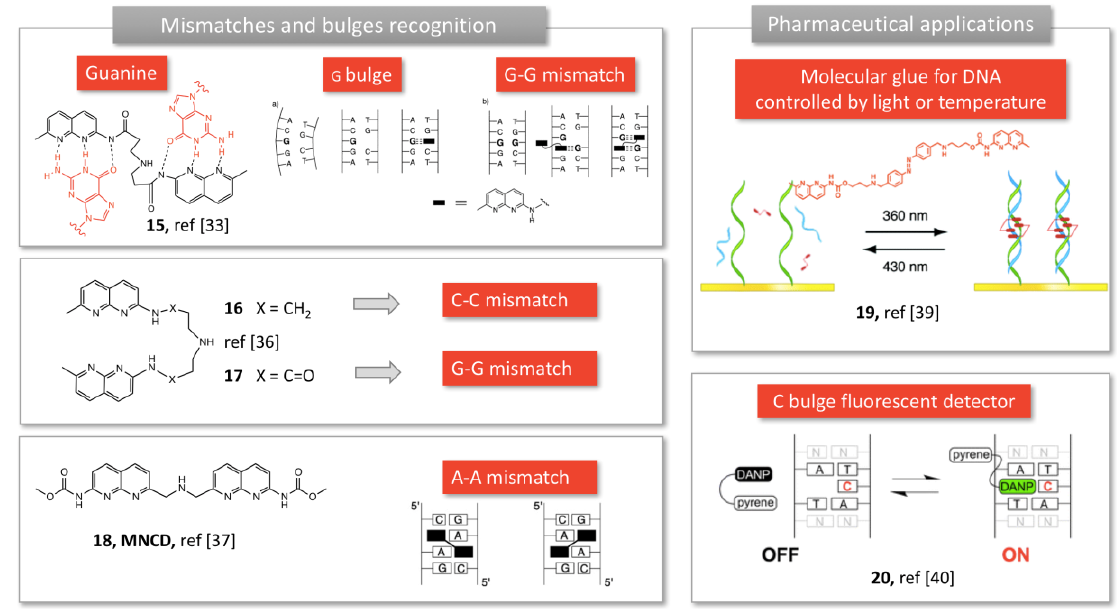
Figure 4. Molecular tweezers developed by Nakatani et al. to detect bulges and mismatches in DNA. Adapted from [33,35 – 37].